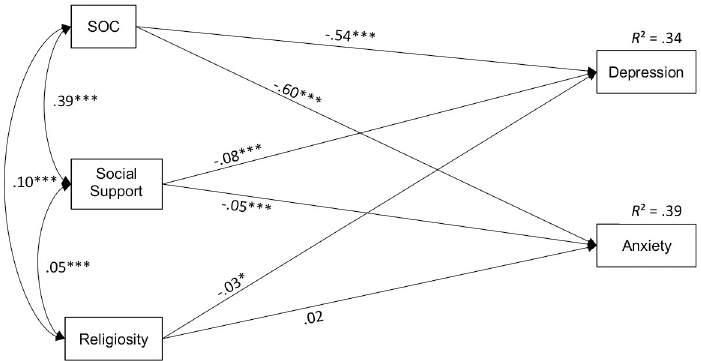
Fig 1. Path diagram to visualize the results of the regression analyses for the total sample. Shown are standard regression weights above the arrows, Pearson’s correlation coefficients between the predictors and adjusted squared multiple correlations for each dependent variable above its box. Control variables included Gender, Age, Professional Experience and Contact with SARS-CoV-2. ��� p < .001. �� p < .01. � p < .05.